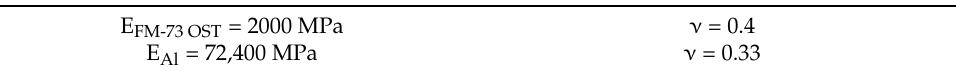
Table 2. FM-73 OST and Al-2014 properties.